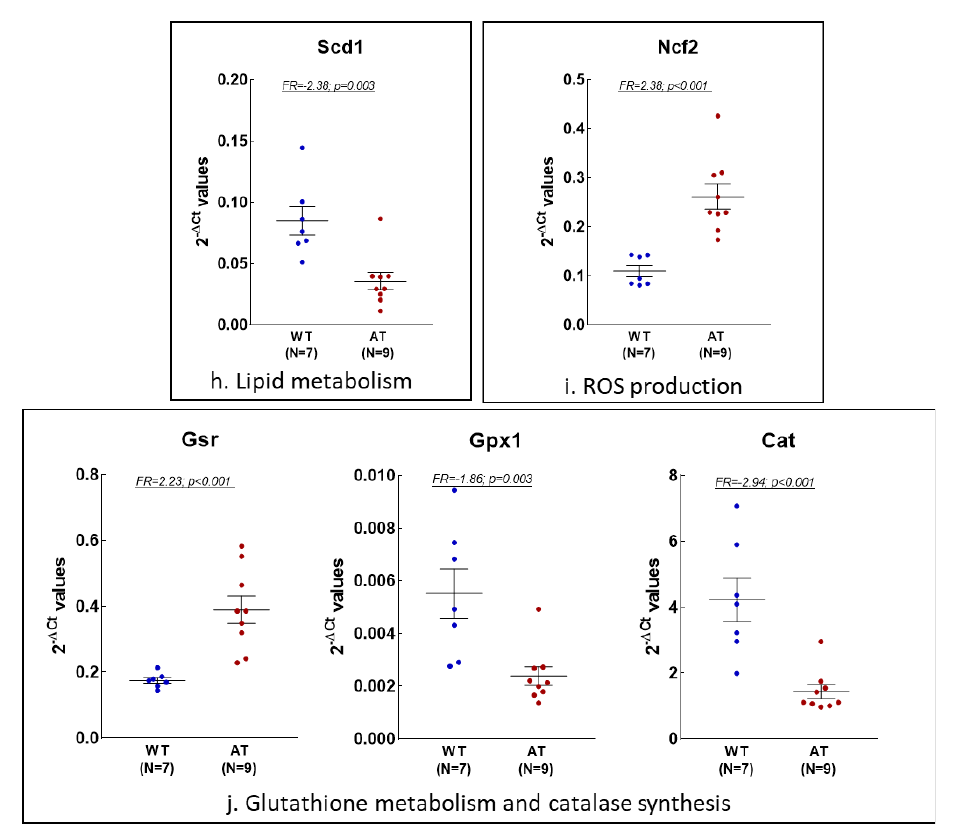
Figure 3. Inflammation and redox-related genes differentially expressed in the whole blood of AT mice (N = 9) vs. WT mice (N = 7), exhibiting |FR| values > 1.8. Data are presented as 2 −∆ CT values, and lines represent the expression average ± standard error of the mean (SEM). Comparisons between mice groups were made using the Mann–Whitney U-test, and differences were considered significant for p < 0.05.